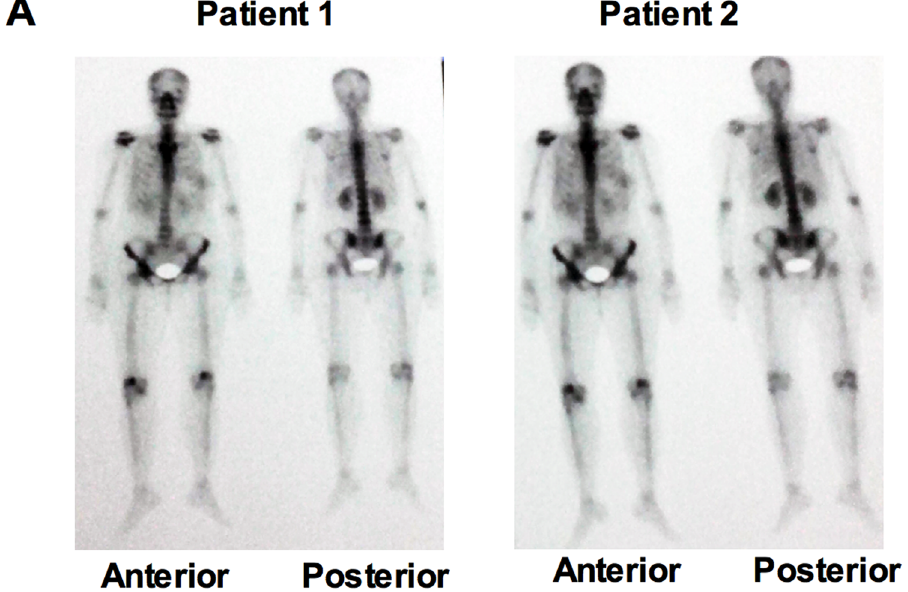
Figure 7. Bone metastasis and elevated levels of Shh and IL-6 in progressive metastatic breast cancer patients. ( A ) Scintigraphic imaging of whole body scan for the detection of bone metastasis from advanced stage progressive metastatic breast cancer patients showing anterior and posterior view of both shoulder and knee